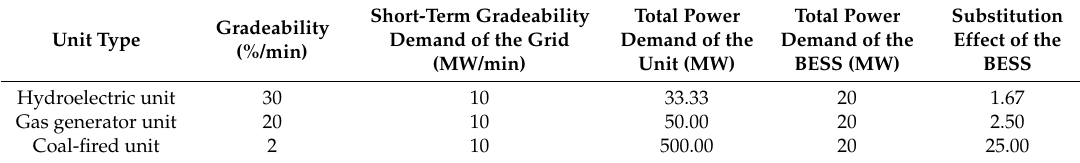
Table 4. Comparison of the battery energy storage system (BESS) and conventional power